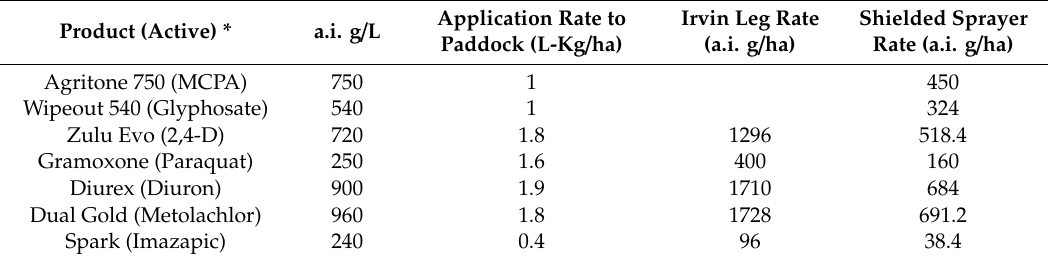
Table 2. Details of treatment herbicide active ingredient (a.i.) application